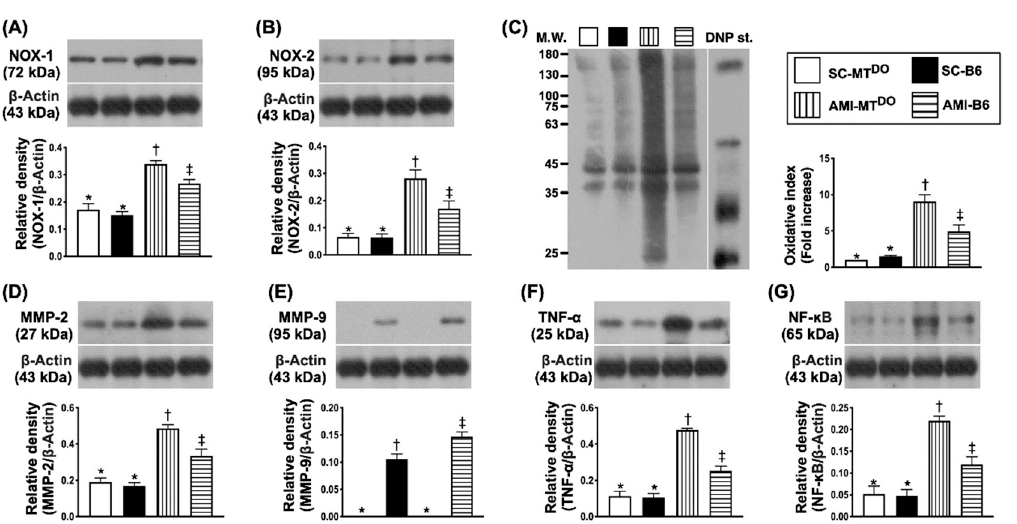
Figure 4. Protein expressions of oxidative-stress and inflammatory biomarkers in LV myocardium by 60 days after AMI procedure. ( A ) Protein expression of NOX-1, * vs. other groups with di ff erent symbols ( † , ‡ ), p < 0.0001. ( B ) Protein expression of NOX-2, * vs. other groups with di ff erent symbols ( † , ‡ ), p < 0.0001. ( C ) Oxidized protein expression, * vs. other groups with di ff erent symbols ( † , ‡ ), p < 0.0001. (Note: left and right lanes shown on the upper panel represent the protein molecular weight marker and control oxidized molecular protein standard, respectively). M.W. = molecular weight; DNP = 1-3 dinitrophenylhydrazone. ( D ) Protein expression of matrix metalloproteinase (MMP)-2, * vs. other groups with di ff erent symbols ( † , ‡ ), p < 0.0001. ( E ) Protein expression of MMP-9, * vs. other groups with di ff erent symbols ( † , ‡ ), p < 0.0001. ( F ) Protein expression of tumor necrosis factor (TNF)- α , * vs. other groups with di ff erent symbols ( † , ‡ ), p < 0.0001. ( G ) Protein expression of phosphorylated nuclear factor (p-NF)- κ B, * vs. other groups with di ff erent symbols ( † , ‡ ), p < 0.0001. All statistical analyses were performed by one-way ANOVA, followed by Bonferroni multiple comparison post hoc test ( n = 6 for each group). Symbols (*, † , ‡ ) indicate significance (at 0.05 level). SC = sham-operated control; MT DO = double knock out of matrix metalloproteinase (MMP)-9 and tissue plasminogen (tPA) in mice; B6 (i.e., wild type) = C57BL / 6 mice. LV = left ventricular; AMI = acute myocardial infarction.